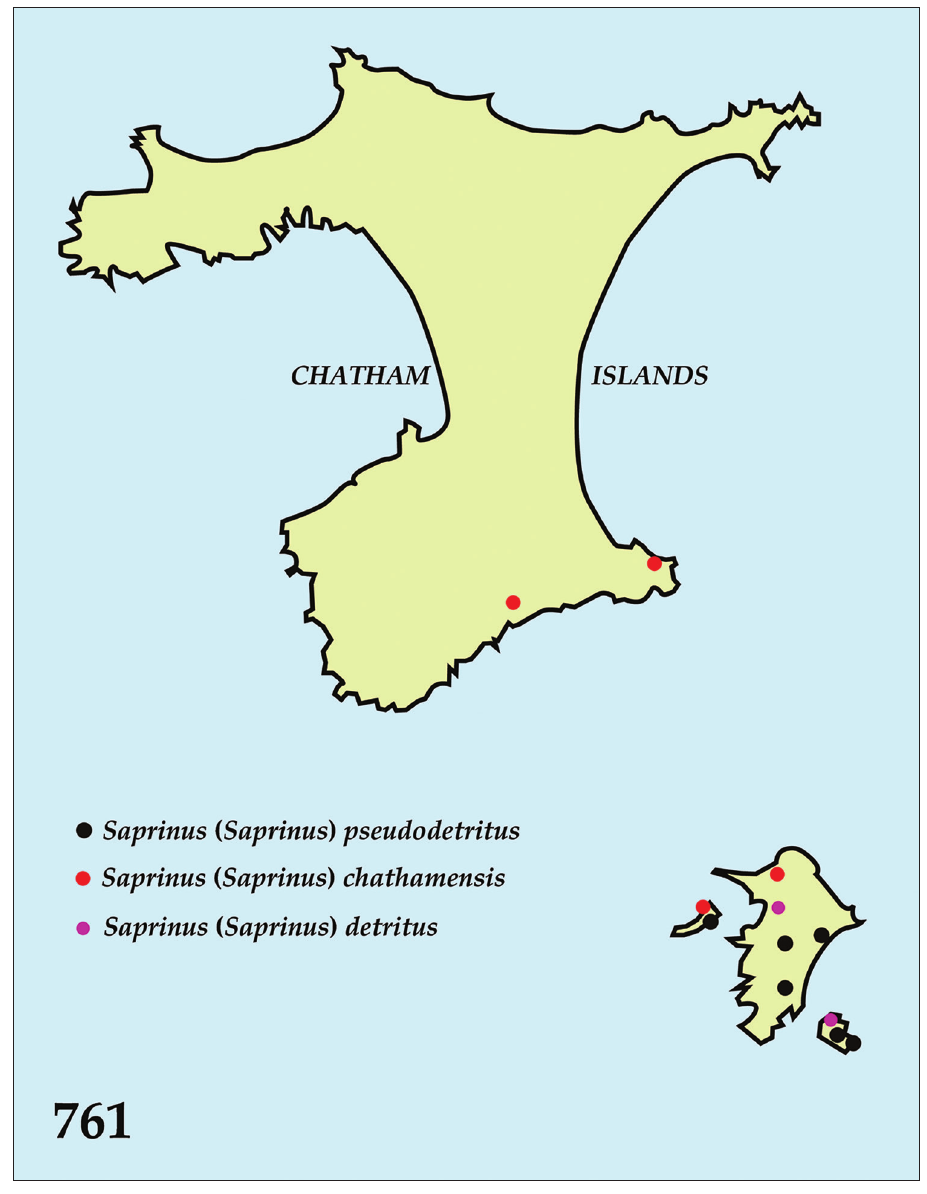
Figure 761. Distribution of the genus Saprinus Erichson, 1834 on the Chatham Islands: Saprinus ( Sap- rinus ) chathamensis sp. n.; Saprinus ( Saprinus ) detritus (Fabricius, 1775) and Saprinus ( Saprinus ) pseudo- detritus sp.